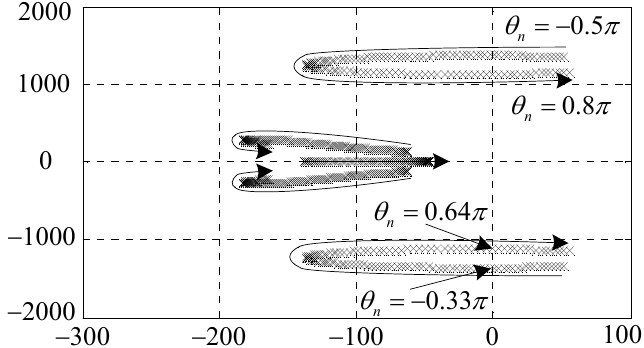
Figure 6. Root locus of the clean synchronous i x control subsystem when